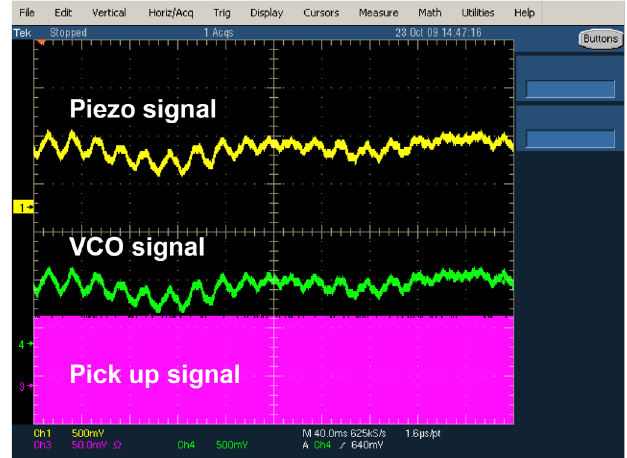
FIG. 2. (Color) Test of the piezo tuning system compensating frequency changes at 4